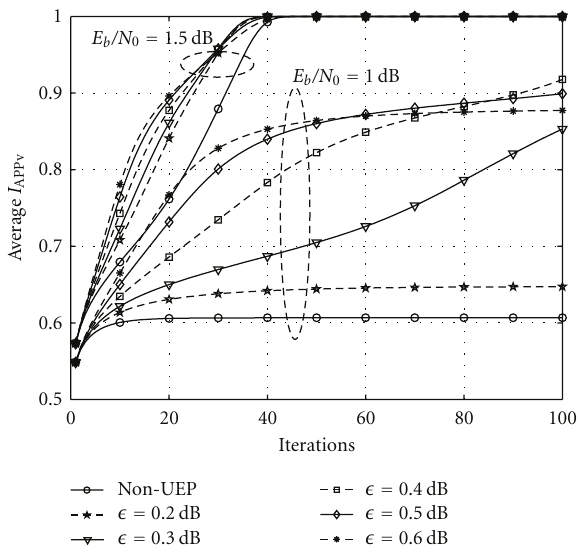
Figure 1: Average a posteriori variable node MI as a function of decoder iterations for six di ff erent PEG-ACE codes with n = 2048 and d v max = 20. For a low number of iterations, a large (cid:2) gives fast convergence for both E b /N 0 shown. For a larger number of iterations (around 60), (cid:2) = 0 . 5 dB gives the highest MI at E b /N 0 = 1dB, and (cid:2) = 0 . 3 dB gives the highest MI at E b /N 0 = 1 . 5